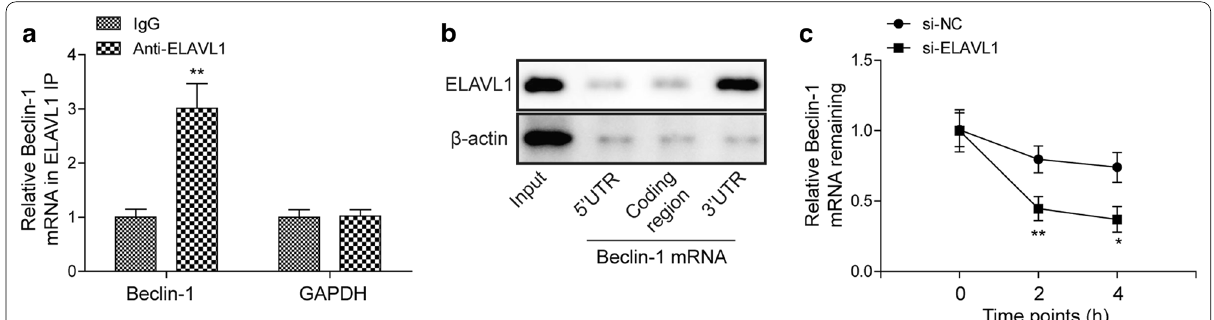
Fig. 6 ELAVL1 directly binds and stabilizes Beclin‑1 mRNA. a Relative Beclin‑1 mRNA and GAPDH mRNA levels following ELAVL1 immunoprecipitation. b Relative ELAVL1 protein level following biotin pull‑down. c Relative Beclin‑1 mRNA levels in transfected cells following actinomycin D treatment. The results were presented as the mean